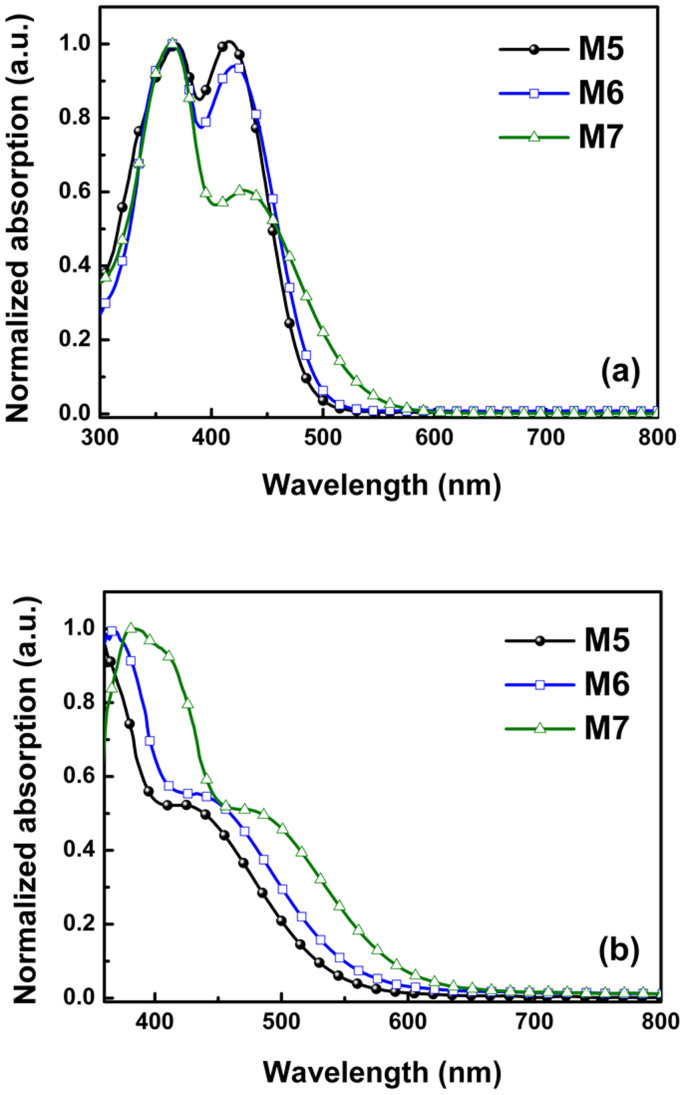
Optical properties of M series dyes.(a) UV-vis absorption spectra in THF. (b) UV-vis absorption spectra on 2-μm-thick TiO2 films.